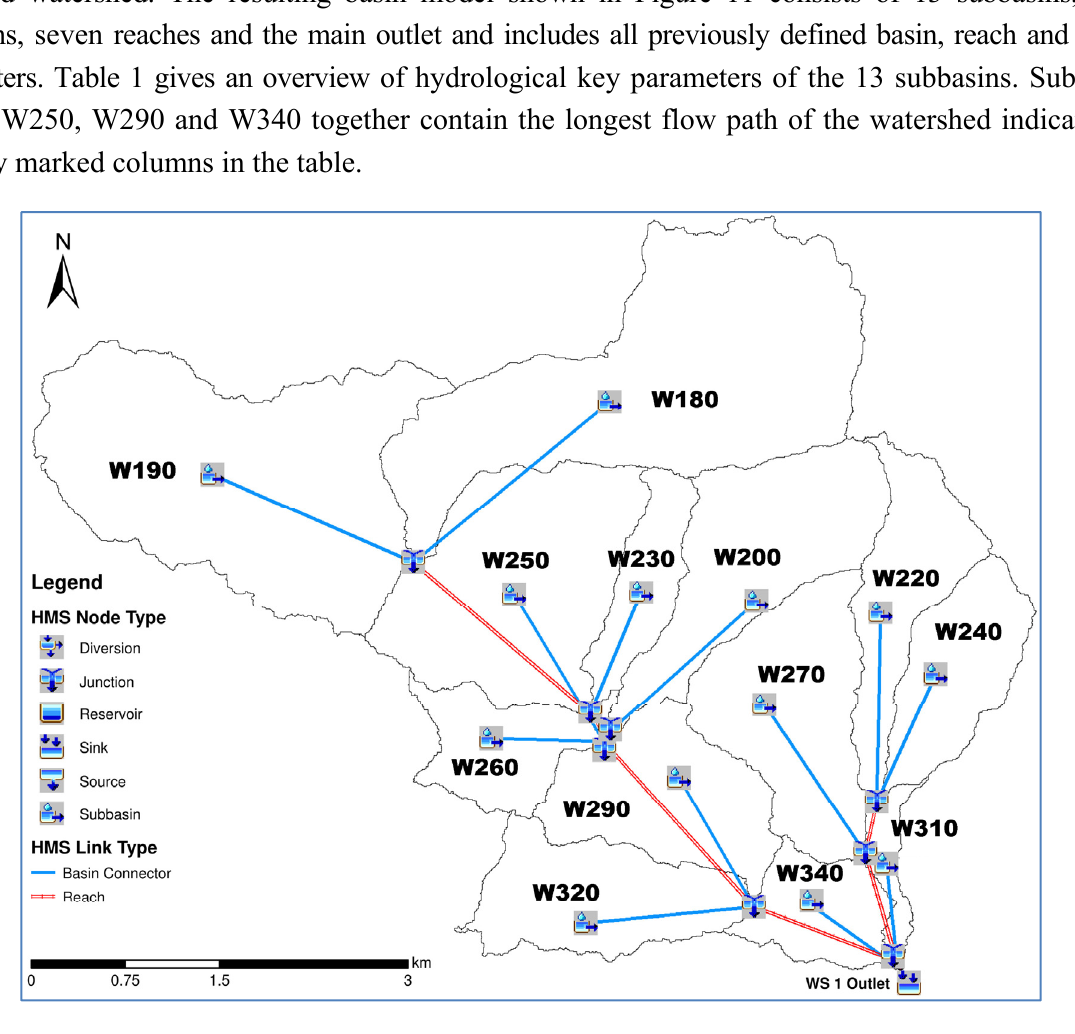
Figure 11. Model representation of the Ravine Lan Couline watershed in